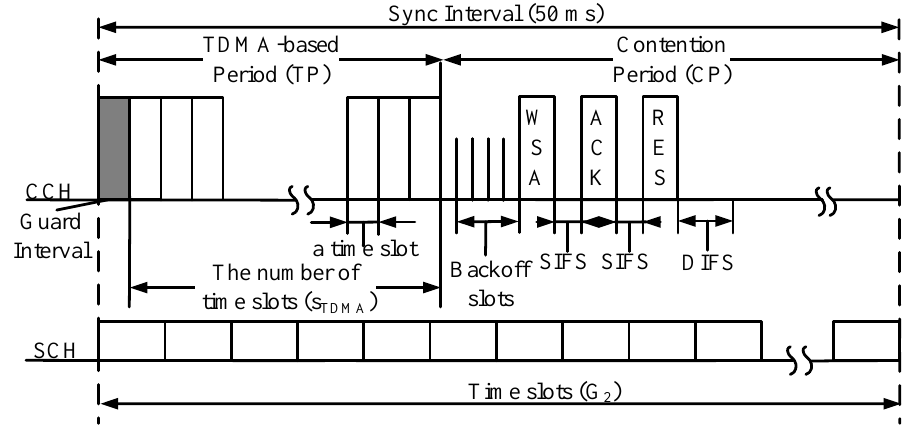
Figure 1. The considered multi-channel MAC